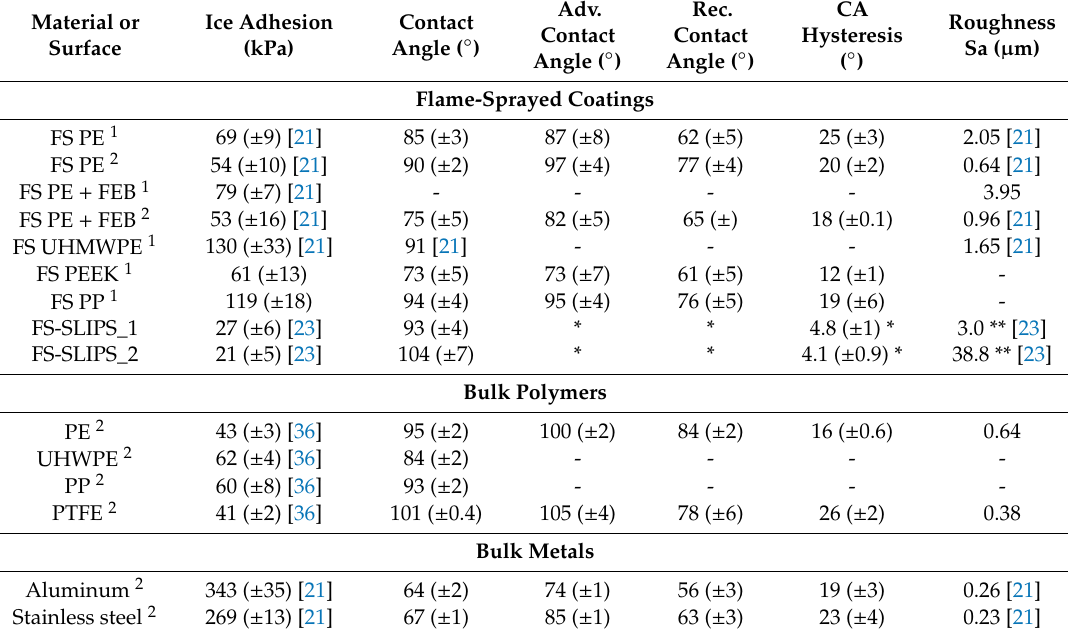
Table 2. Overview of the results divided by different material groups. Ice adhesion, contact angle (CA), advancing contact angle (ACA), receding contact angle (RCA), contact angle hysteresis (CAH) and surface roughness (Sa) of the materials and surfaces (± standard deviation).